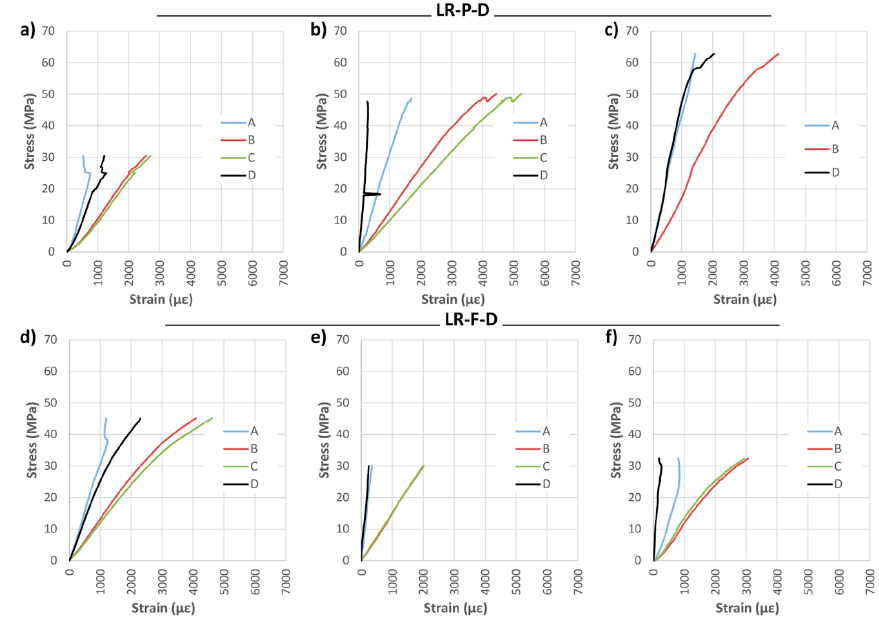
Figure 13. Stress against strain during bending tests: ( a ) LR-P-D-1; ( b ) LR-P-D-2; ( c ) LR-P-D-3; ( d ) LR-F-D-1; ( e ) LR-F-D-2; and ( f ) LR-F-D-3. CFRP supplier: DRIZORO ® .